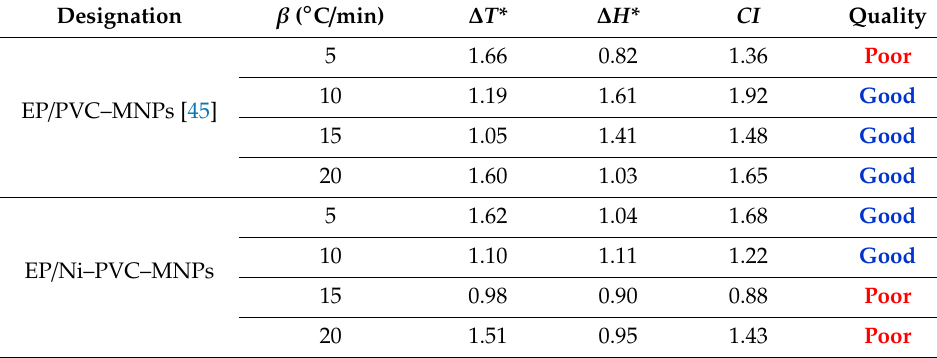
Table 2. Cure state parameters of